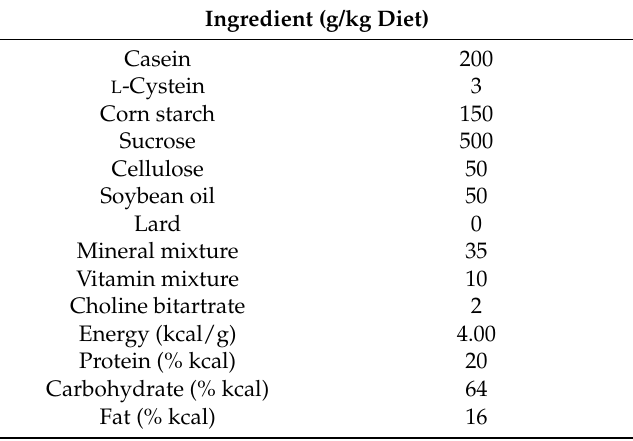
Table 1. Ingredient of diets used in this